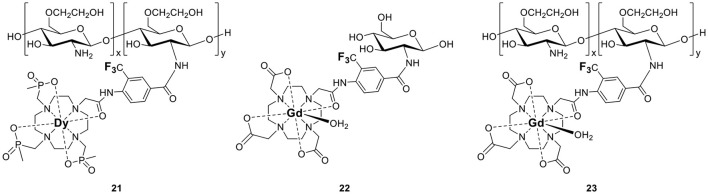
Non-responsive polymeric paramagnetic fluorine probes (21–23, De Luca et al., 2014).